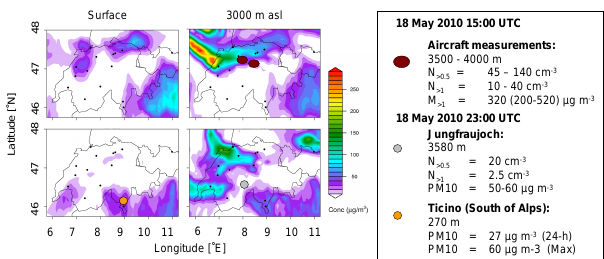
Fig. 16. 18 May 2010: comparison of the simulated volcanic ash concentration (surface and 3000ma . s . l . ) with the number and/or mass concentration values retrieved from the in-situ